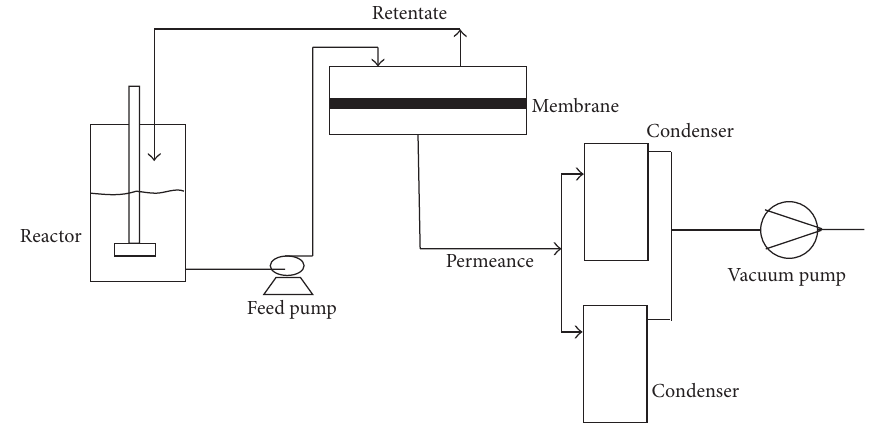
Figure 2: Schematic diagram of pervaporation-chemical reactor integrated